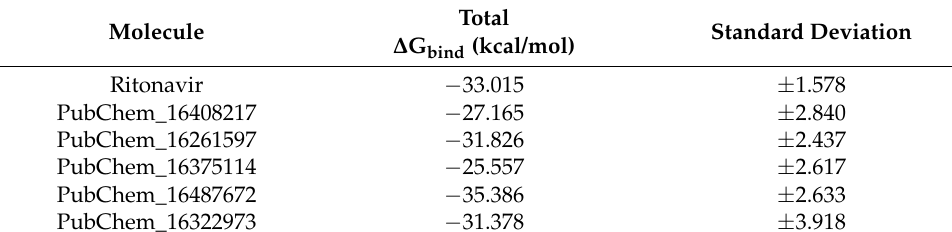
Total Standard Deviation ∆ G bind (kcal/mol)